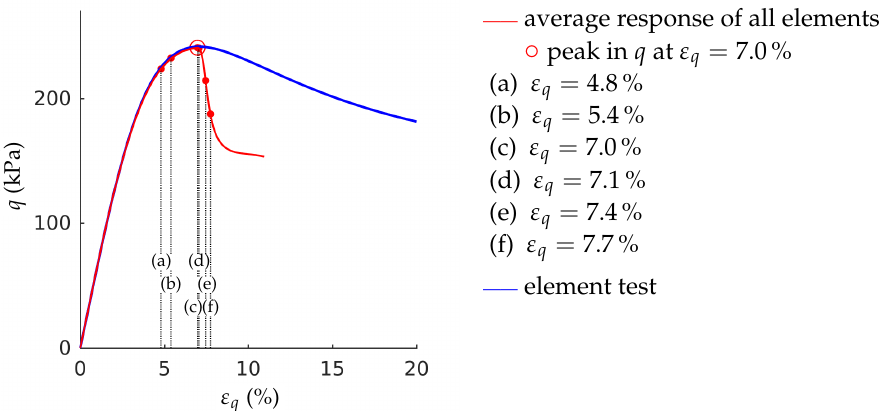
Figure 12. OCR = 6: The global deviatoric strain ε q marked with ( a – f ) corresponds to Figure 8a–f.